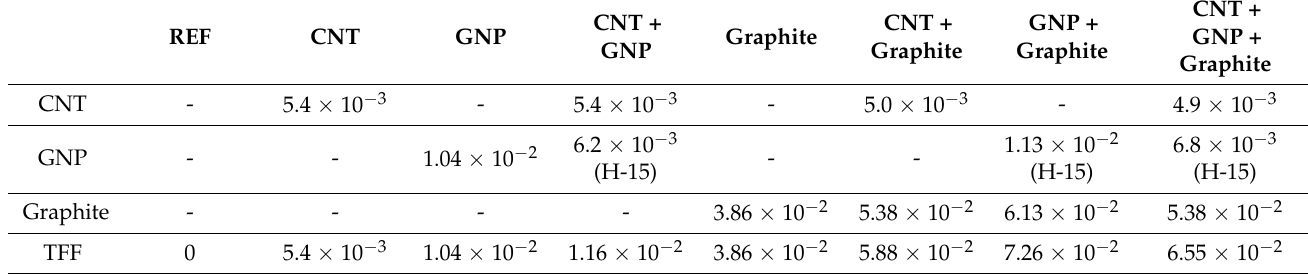
Table 3. The concentration (in weight fraction) of the carbon-based fillers in the tread rubber mixture and the total filler weight fraction (TFF). All systems include 50 phr CB.